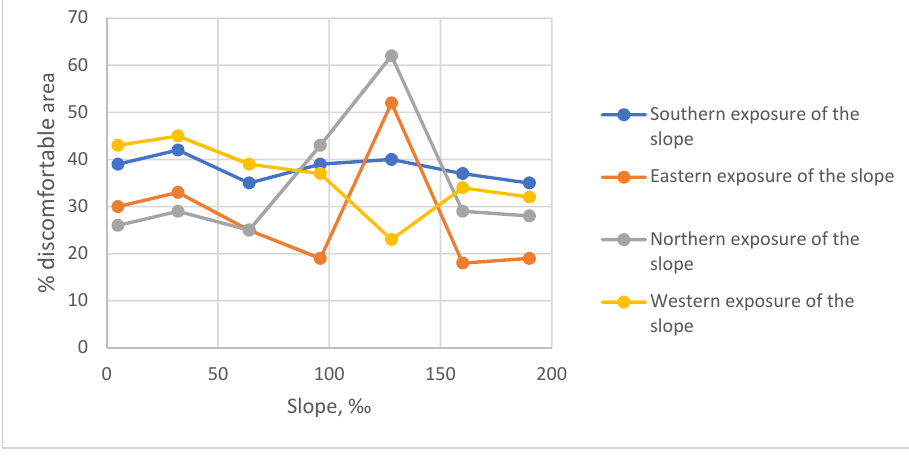
Figure 13. Dependence of k on the slope gradient for the ribbon development.